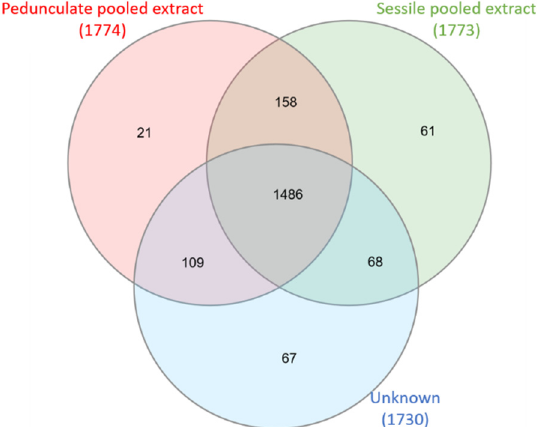
Figure 3. Venn diagram of an unknown individual sample (1 sample) attributed pedunculated com- pared to sessile pooled extracts (21 samples) and pedunculate pooled extracts (21 samples). Num- bers above species represent total precursor ions detected in each extract. The circle overlap repre- sents common ions, and the non-overlapping part represents specific ions. Again, most of the ions are common for the three samples (1486). The number of ions shared only with the pedunculate oak pool (109) is greater than the number of ions shared with the sessile oak pool (68), in favor of a suitable assignment. Some ions (67) are specific to the individual, which can be explained by the high intra-individual variability even within the same species.